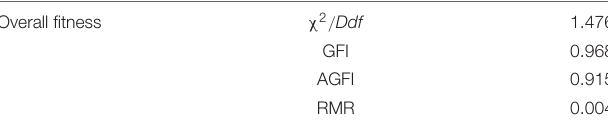
TABLE 5 | Analysis results of the overall fitness of the linear structural relation (LSR)